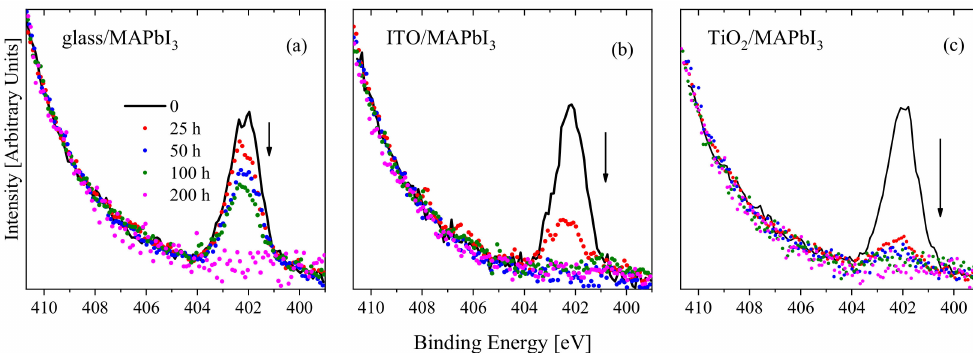
Figure 5. XPS N 1s spectra normalized on Pb 5d-line of light-soaked MAPbI 3 hybrid perovskites prepared on different substrates: ( a ) glass, ( b ) ITO, and ( c ) TiO 2 substrates.